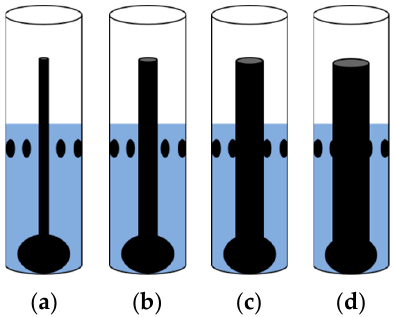
Figure 6. Schematic of ABS phantom placement middle of the sensor: ( a ) 10 mm ( b ) 20 mm ( c ) 30 mm ( d ) 40 mm.